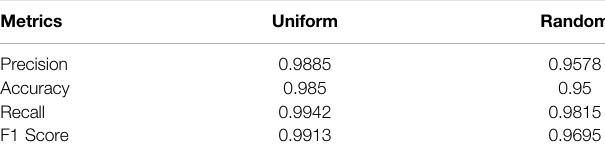
TABLE2| Summaryofthemetricsforuniformandrandomloadcasesindicatethe quality of training. Metrics